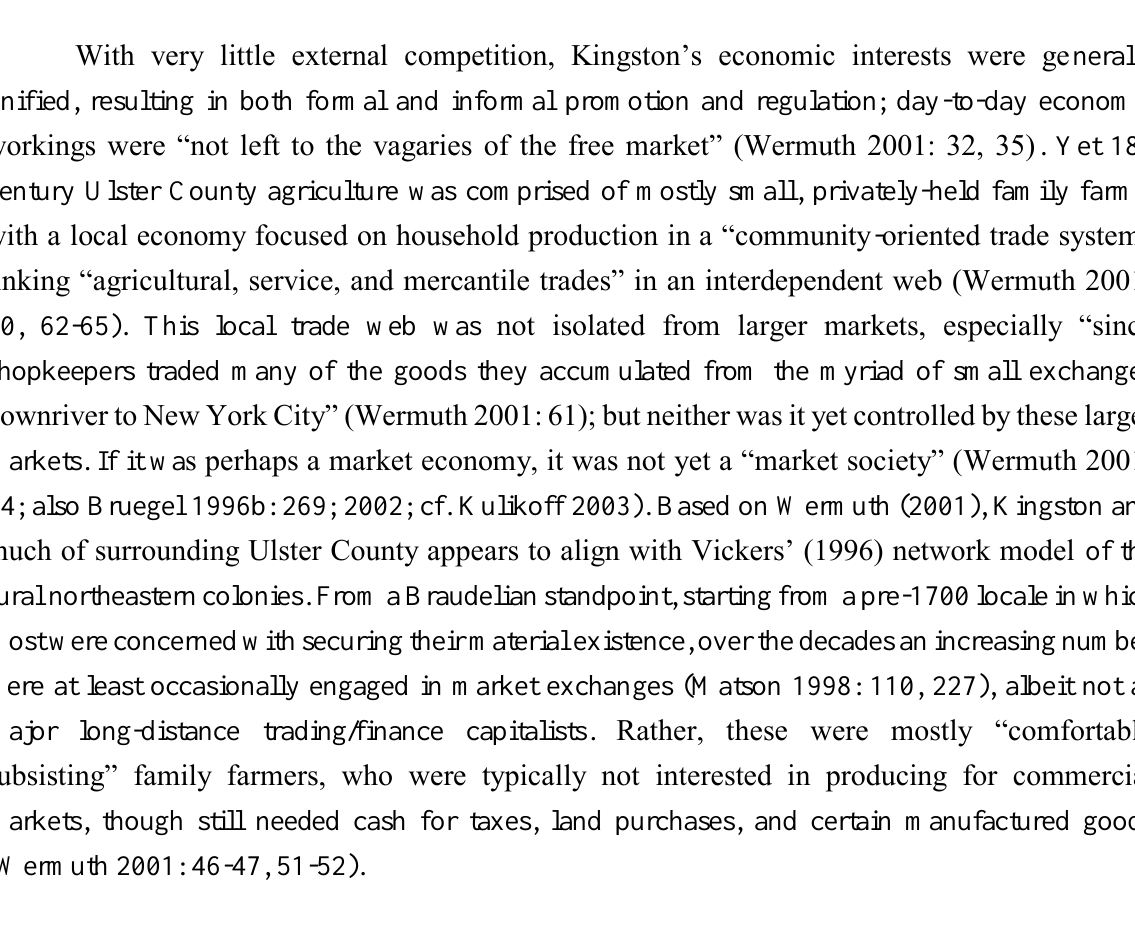
Table 1: Ulster Co. Population (includes black and white residents, except as